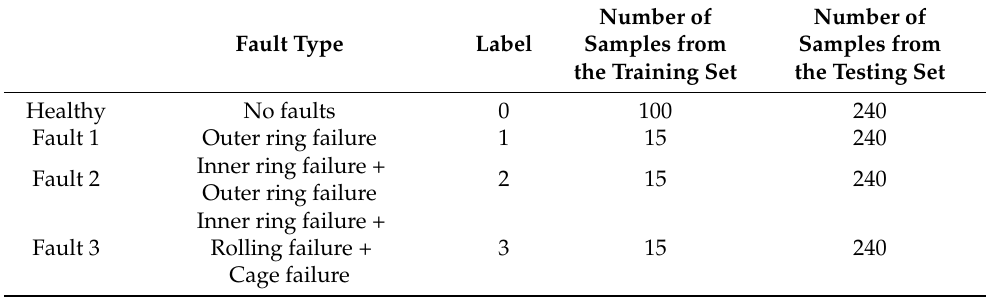
Table 3. Fault description of generator bearings for wind turbines.